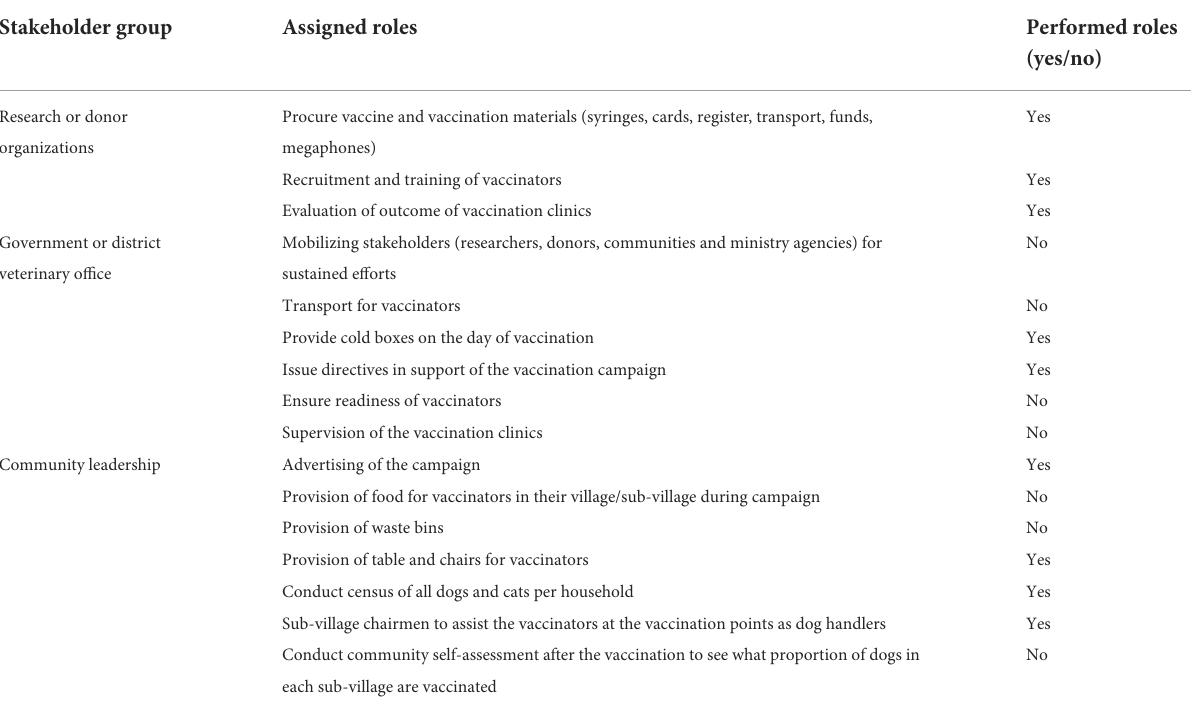
TABLE 4 Outcomes of meeting to involve community leadership in planning and implementing of dog vaccination: roles performed and those not performed. Stakeholder